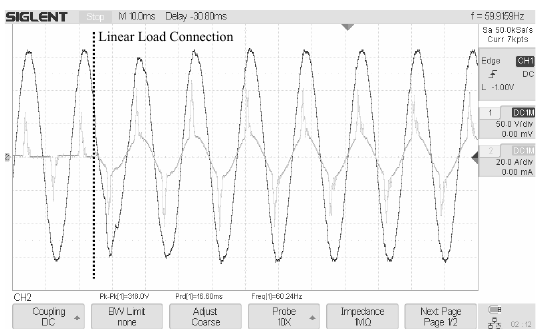
Figure 21. Transient stage for linear load connection when the nonlinear one remains connected.